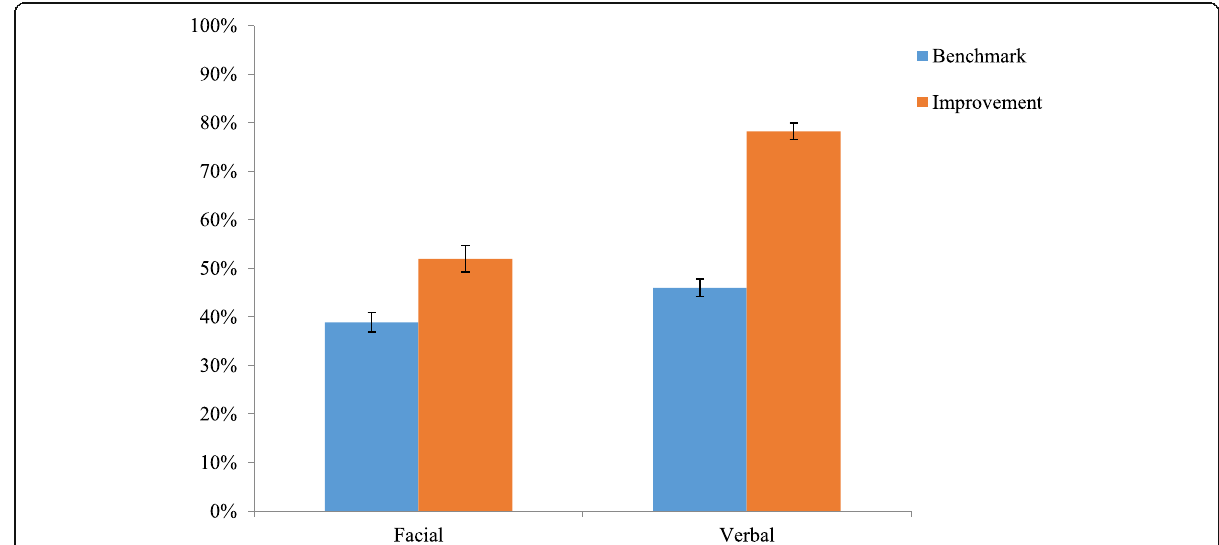
Fig. 1 Efficacy of training. Note, bars represent standard error of the mean